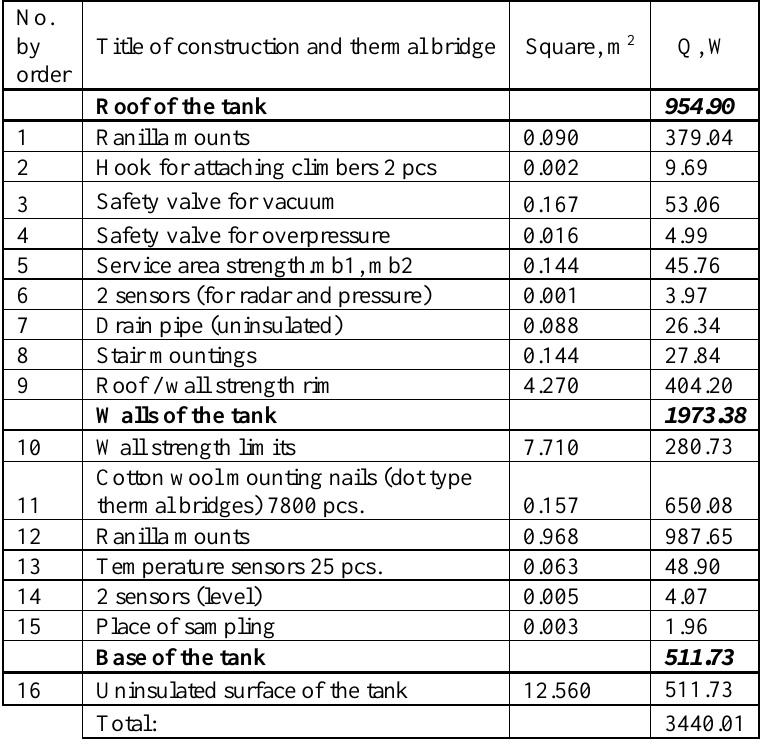
Table 2. Heat accumulator thermal bridge areas and